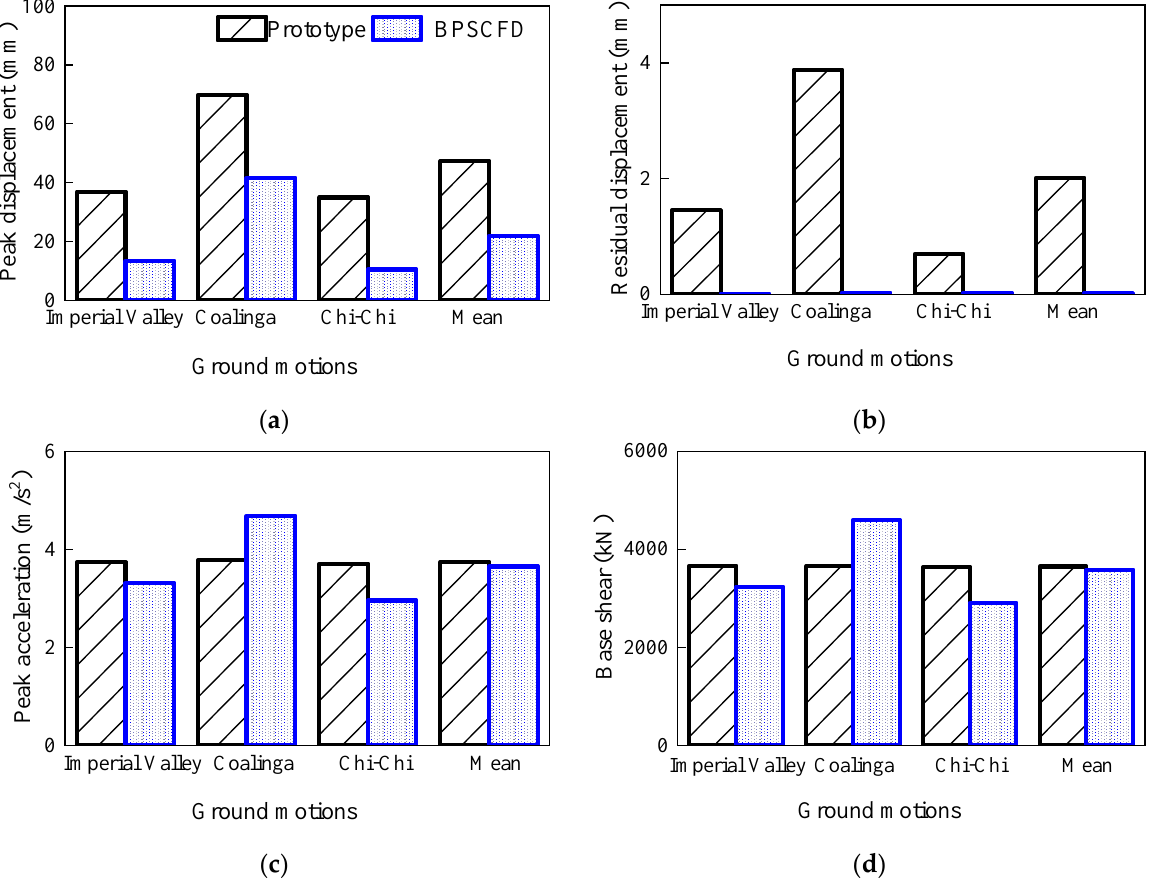
Figure 17. Responses of bridges with or without BPSCFDs: ( a ) peak displacement, ( b ) residual dis- placement, ( c ) peak acceleration, ( d ) peak base